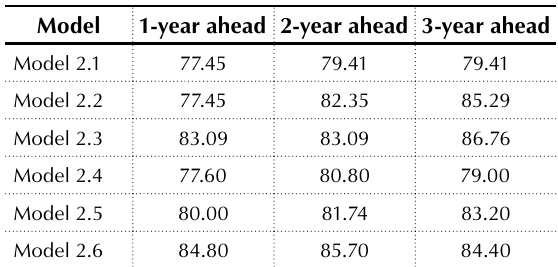
Compared to the Type I error calculation in the logistic regression model with the same data set and time of prediction, Type I error in the SVM model is extremely low (Table 9). In particu- lar, there is no Type I error that can be detected in model 2.2 and model 2.3 and 2.3 for 3 years of prediction.